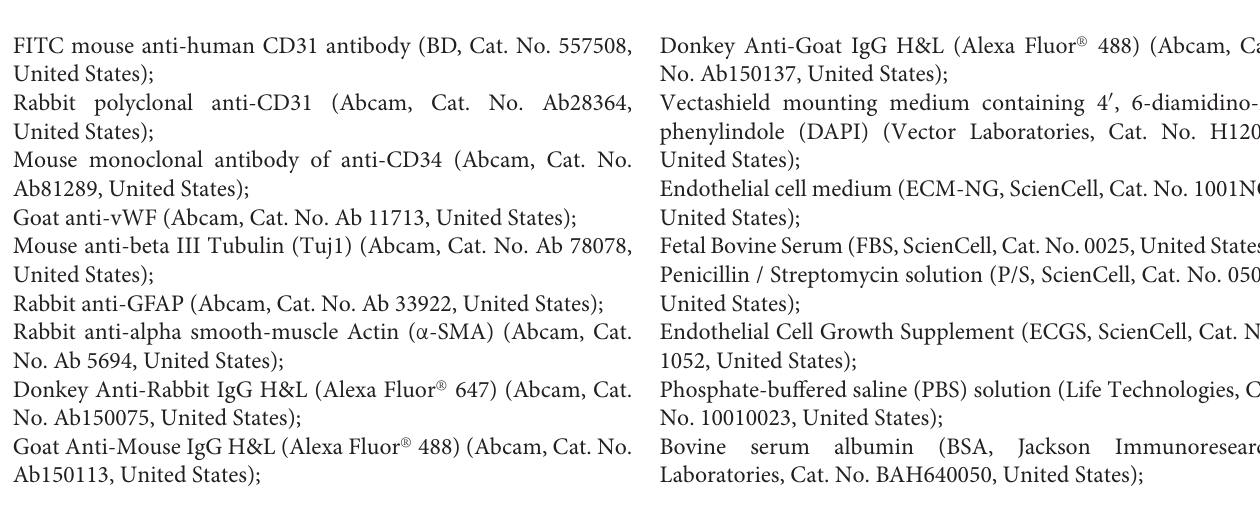
FIGURE 3 | Experimental procedure to isolate cAVM-ECs. (A) Original cAVM lesioned tissues were washed with Phosphate-buffered saline (PBS); (B) the disordered vessels in the cAVM nidus, showing thin and lucid vessel layers; (C) disordered vessels in the cAVM nidus were cut into small cubes and digested in Trypsin-EDTA; (D) The isolated cells were cultured in conditional